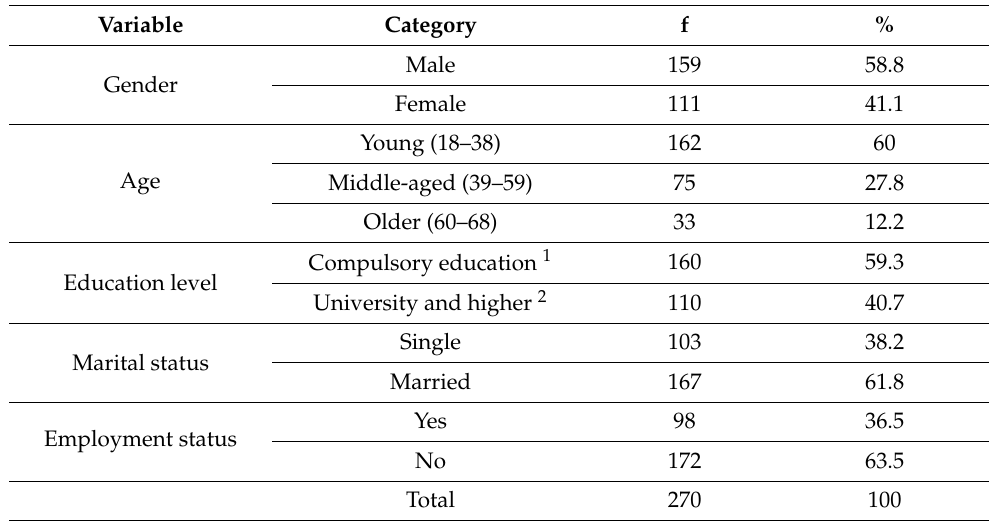
Table 2. Basic demographic and socio-economic information for